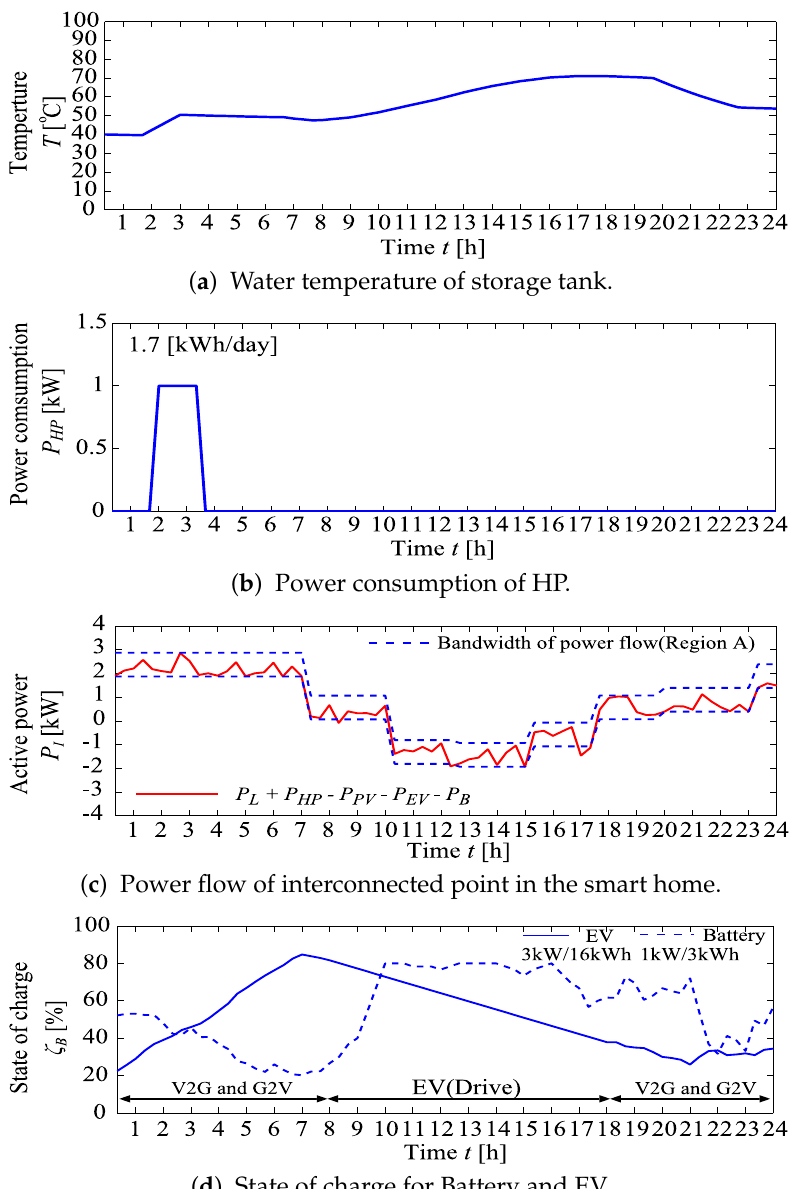
Figure 9. Simulation results with considering uncertainties, without considering re-forecast and re-plan on a fair day (Case